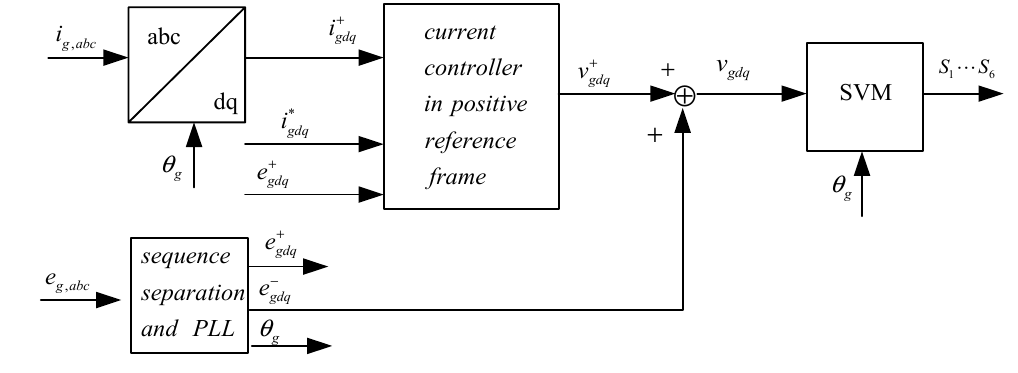
Figure 6. Control block diagram of VCCF.